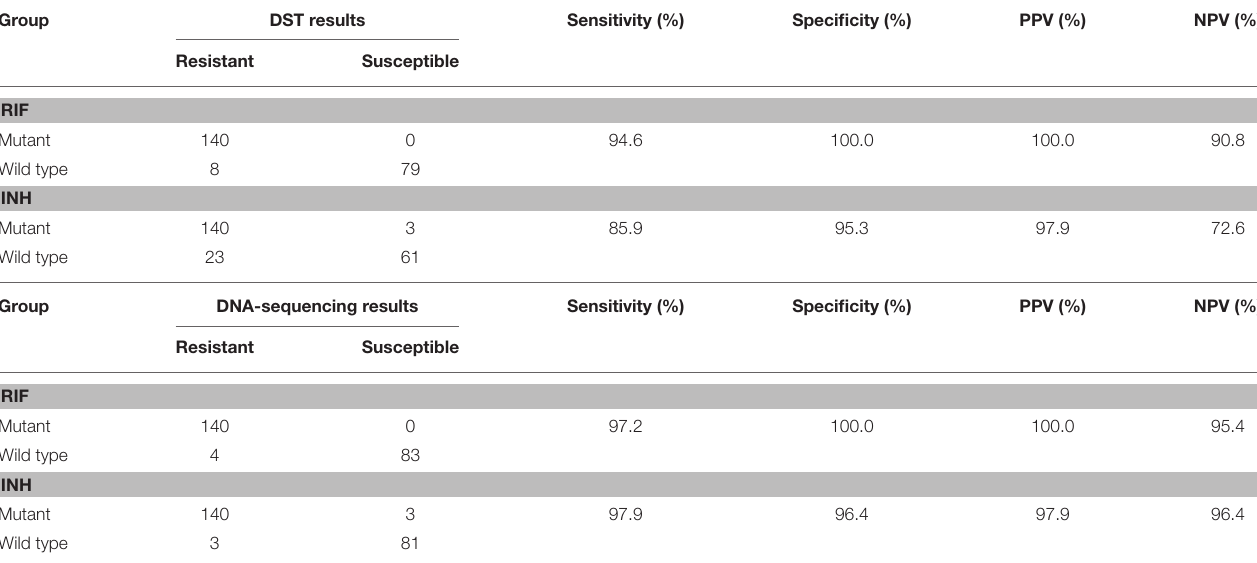
TABLE 3 | Sensitivities and specificities of multi-fluorescence real-time PCR compared to DST and DNA-sequencing results. Group DST results